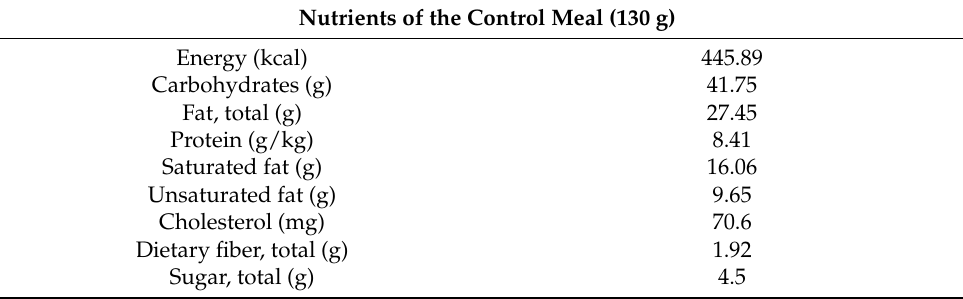
Table 1. Dietary composition of the Control meal